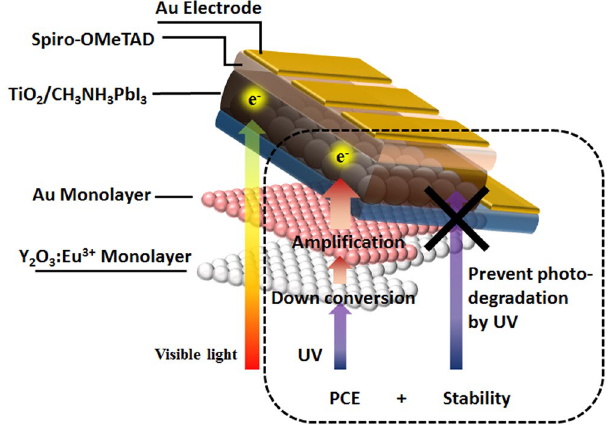
Figure 7. Scheme of dual function smart film. Schematic illustration of dual function Au@Y 2 O 3 :Eu 3 + hybrid smart film of the perovskite solar cell.